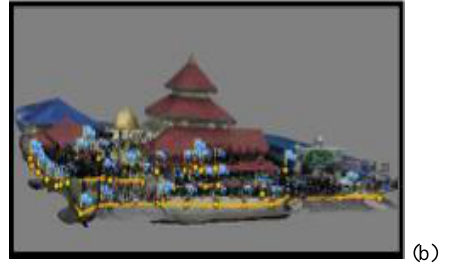
Figure 3. Mark point using Agisoft software; a) images, b) 3D Model Table 2. Comparison Actual and Measured Value